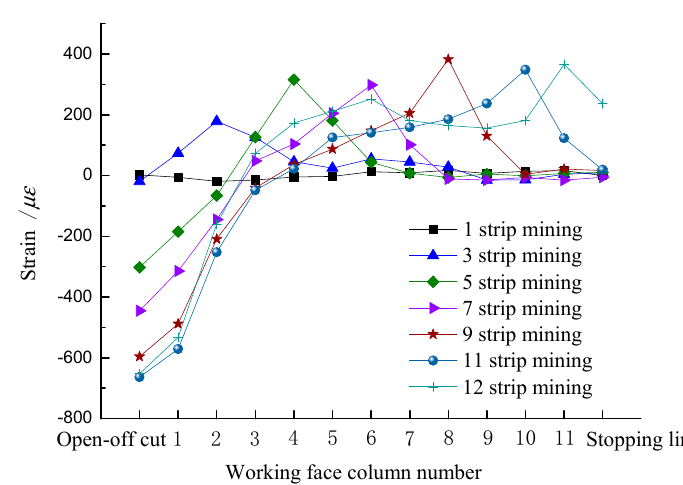
Figure 4. Strain change and distribution map of each pillar in layer I along with excavation of the coal face.